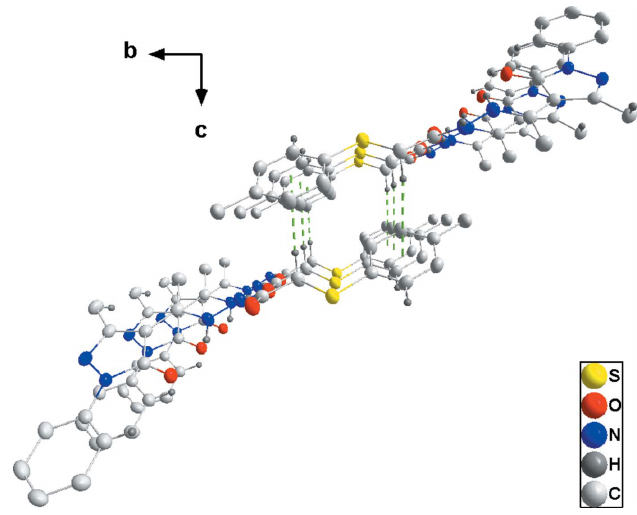
Figure 3 Elevation view of the packing along the a -axis direction, showing the connecting of two layers through C—H (cid:3)(cid:3)(cid:3) (cid:2) interactions.